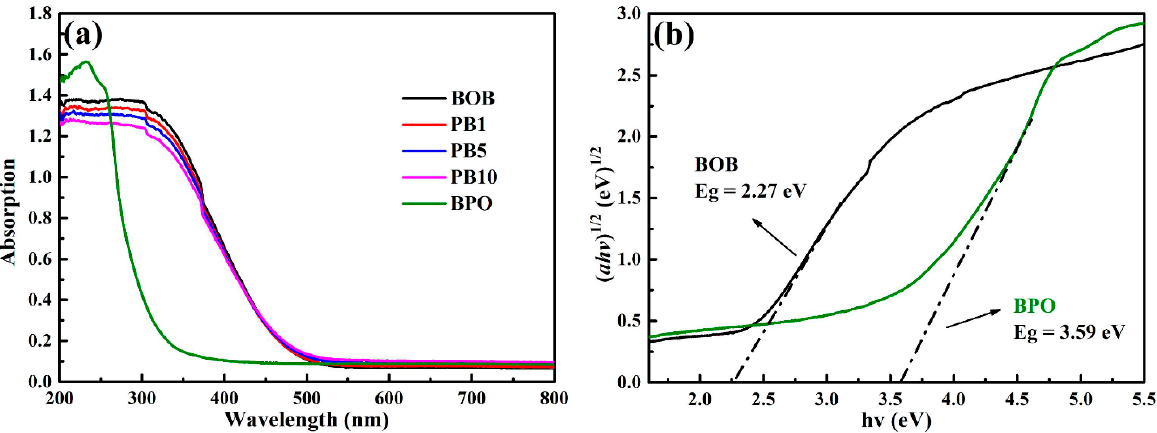
Figure 3. UV-Vis DRS spectra of BOB, BPO, and the PBX series ( a ); bandgap energy estimation of BOB and BPO ( b ).